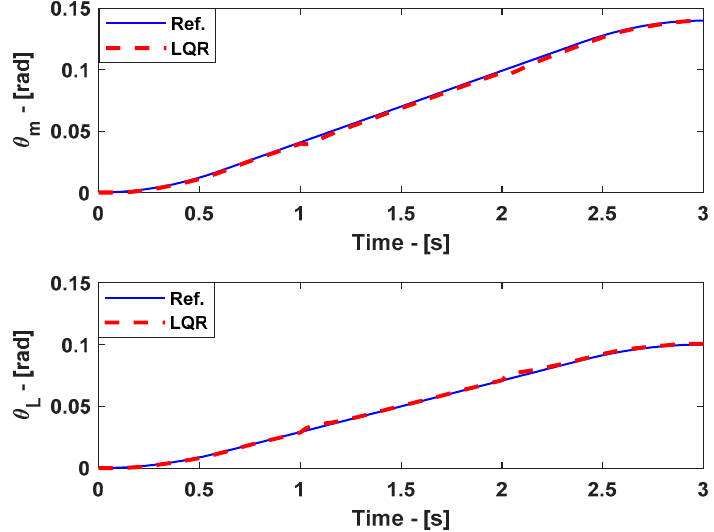
Figure 6. The responses of DVSA based on the LQR scheme in the scenario of altering the status of clutches while the system is running. ( Top ) the input trajectory response; ( Bottom ) the output re- sponse.